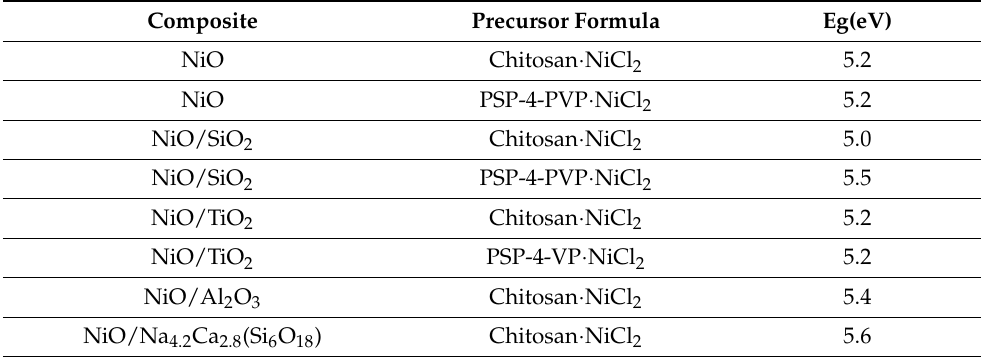
Table 2. E g values for NiO and NiO included in the SiO 2 , TiO 2 , Al 2 O 3 , and Na 4.2 Ca 2.8 (Si 6 O 18 ) matrices Adapted from reference [65].